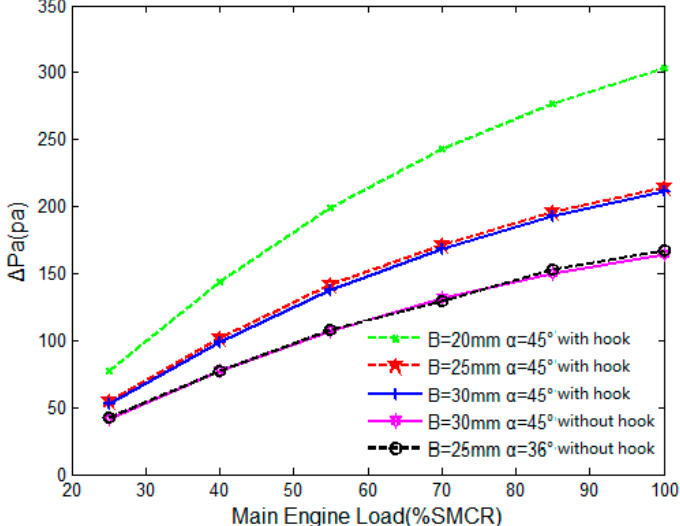
Figure 6. Influence of corrugated plate spacing on the total pressure loss.